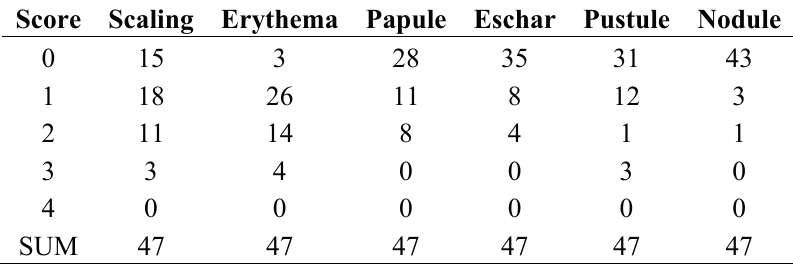
Table 1. Scalp skin symptoms of